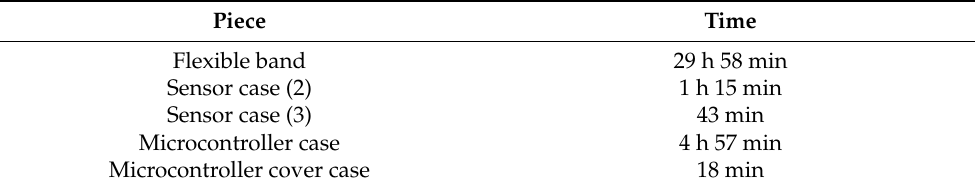
Table 2. Printing times.